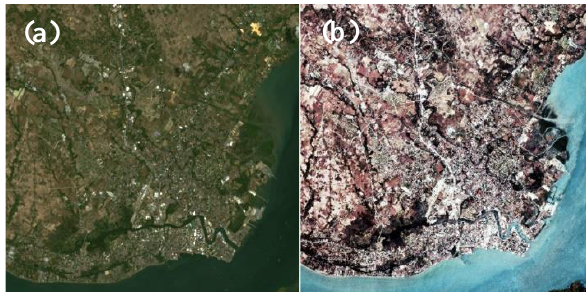
Figure 2. (a) Landsat OLI and (b) PlanetScope True Color